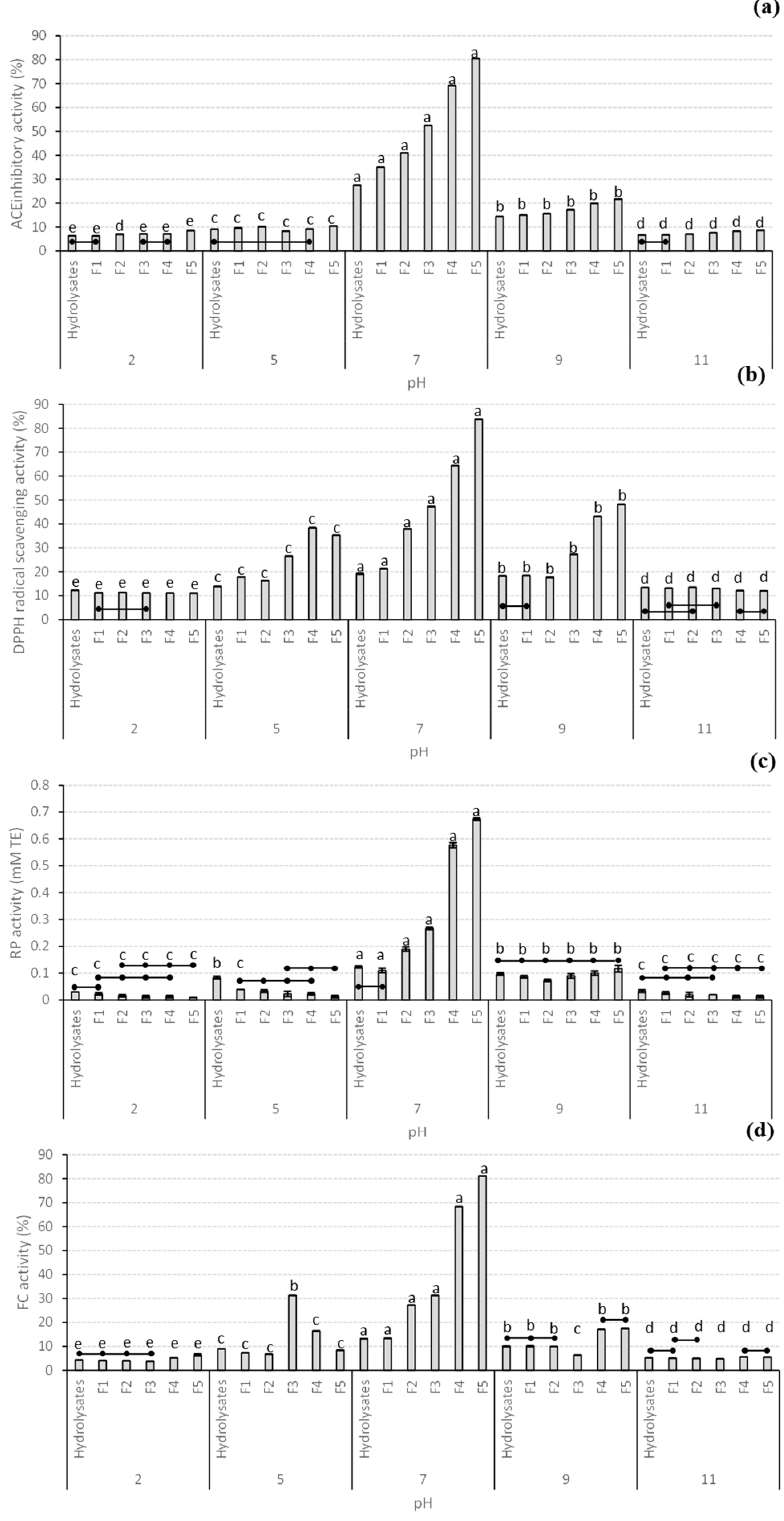
Figure 3. Stability of the biological activities in vitro ( a ) ACE inhibitory activity (%), ( b ) DPPH radical scavenging activity (%), ( c ) RP activity (mM TE) and ( d ) FC activity (%) of giant kelp protein hydrolysates and di ff erent MW fractions at various pH (2–11). Data are presented as the average ±